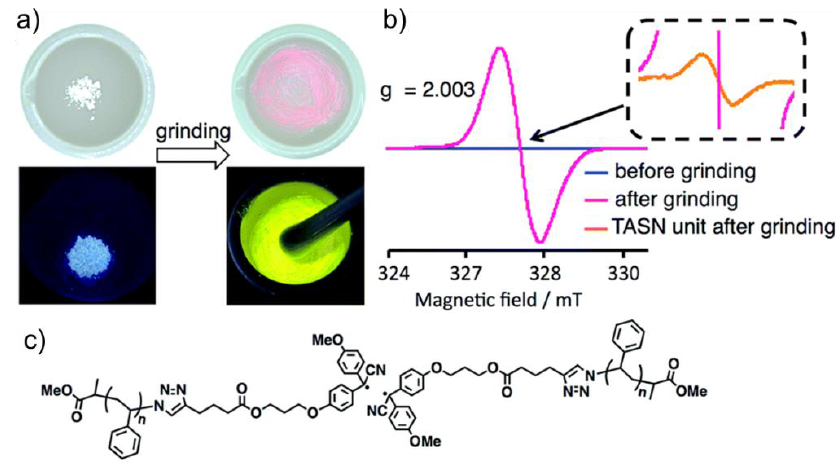
Figure 10. ( a ) Photographs of PS-TASN-PS before and after grinding, and the ground sample under UV irradiation. ( b ) EPR spectra of PS-TASN-PS before and after grinding. ( c ) Chemical structure of radical species derived from PS-TASN-PS. Reproduced with permission from Ref. [95]. Copyright 2022, Royal Society of Chemistry.